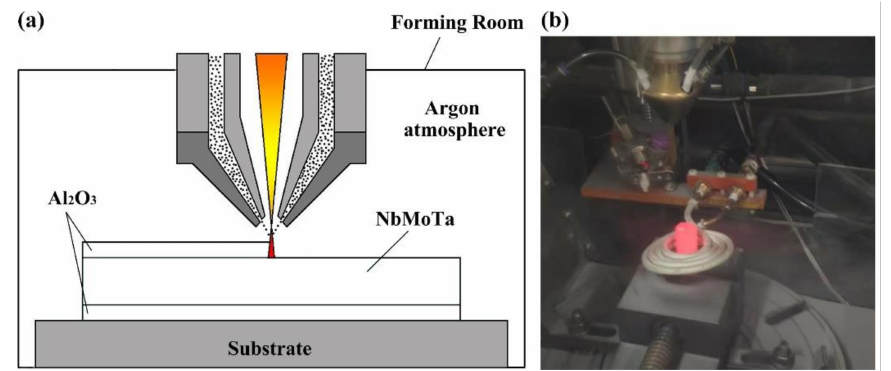
Figure 2. The forming process of the NbMoTa–Al 2 O 3 multilayer composite structure. ( a ) A schematic diagram of the forming process; ( b ) an actual picture of the forming